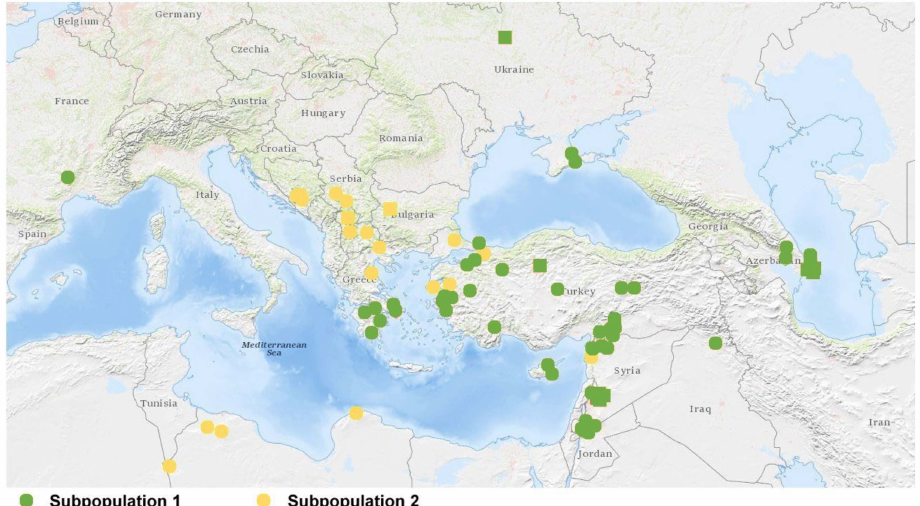
Figure 6. Geographic distribution of Ae. biuncialis accessions. Subpopulation 1 is represented by green symbols, while subpopulation 2 is represented by yellow symbols, as determined by three statistical methods. Circles represent accessions with known geographic locations. If only the country of origin is known, a square representing the capital is used (no information was available for six